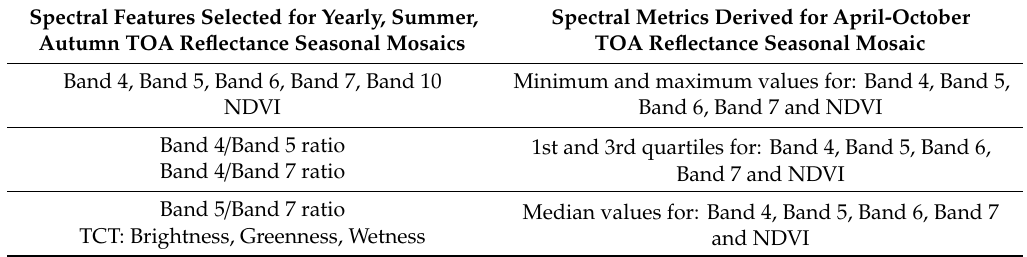
Table 1. The list of predictor variables extracted from seasonal mosaics of Landsat 8 OLI images. Spectral Features Selected for Yearly,